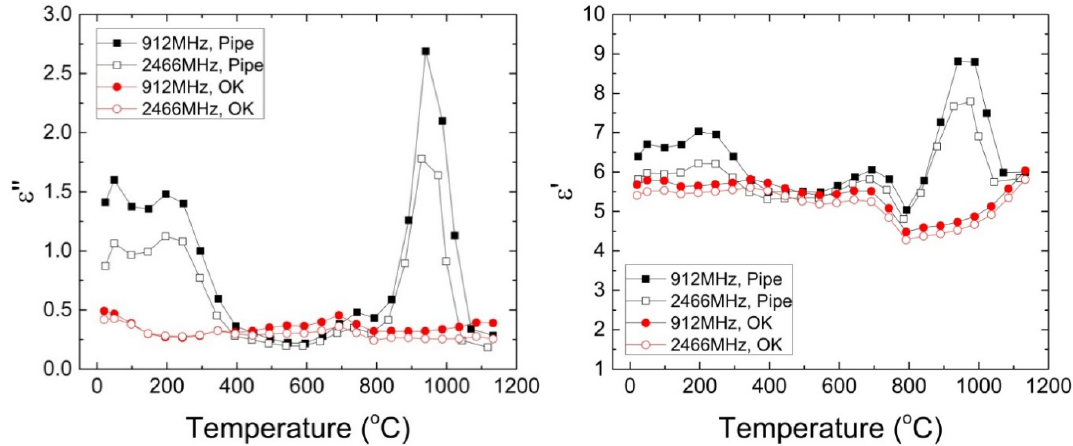
Figure 4. Imaginary permittivity ( left ) and real permittivity ( right ) for the Pipe and OK ores with increasing temperature at frequencies of 912 and 2466 MHz. increasing temperature at frequencies of 912 and 2466